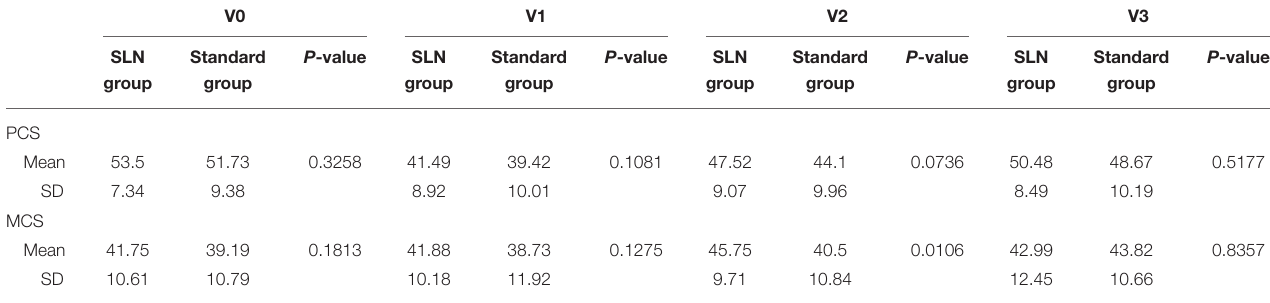
TABLE 2 | Physical and mental component summary